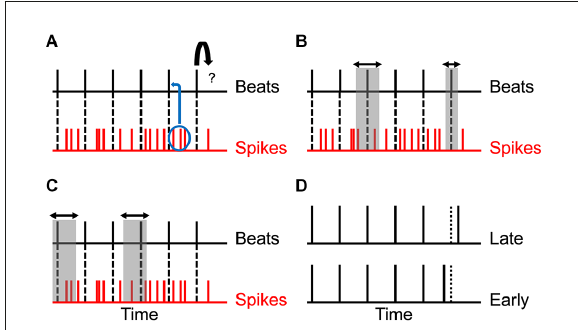
FIGURE1 Theoretical considerations, predictions, and test. (A) Relationship between beats and spikes. The beats are represented by vertical black lines, while the spikes following each beat are represented by vertical red lines. The problem is to predict the next beat (curved arrow). Each beat produces a different train of spikes and so, the timing of beats must be determined probabilistically from the spikes (blue ellipse and curved arrow). (B) Reduction of uncertainty. In an optimal probabilistic estimation, the uncertainty in the timing of the beats decreases as the rhythm progresses (horizontal arrows and vertical gray rectangles). (C) Systematic error. Various factors described in the text contribute to systematic errors in the determination of the times of the beats. Thus, the estimated time may be too early or too late (horizontal arrows and vertical gray rectangles). (D) Test of the Predictions. To test these predictions, we delivered to subjects isochronic stimuli with varying number of beats and inter-beat intervals. However, the last beat was delivered too early or too late and the task of the subject was to guess which was the